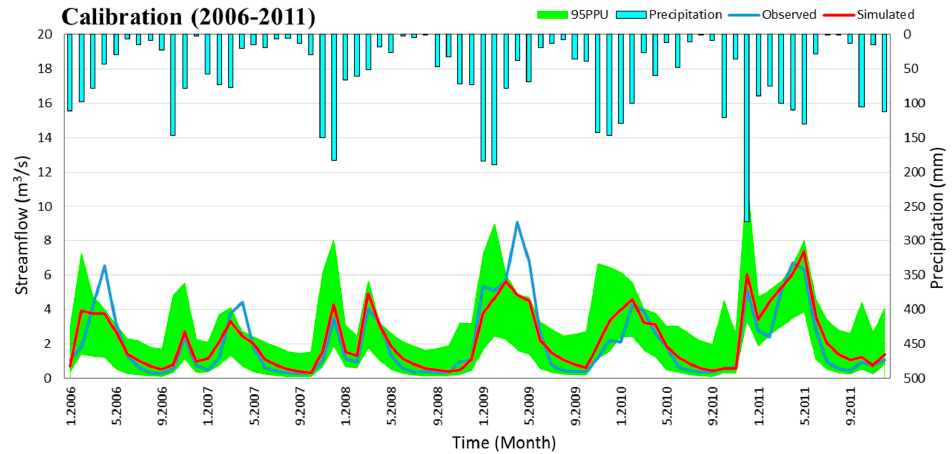
Figure 3. 95PPU graph for calibration stage.